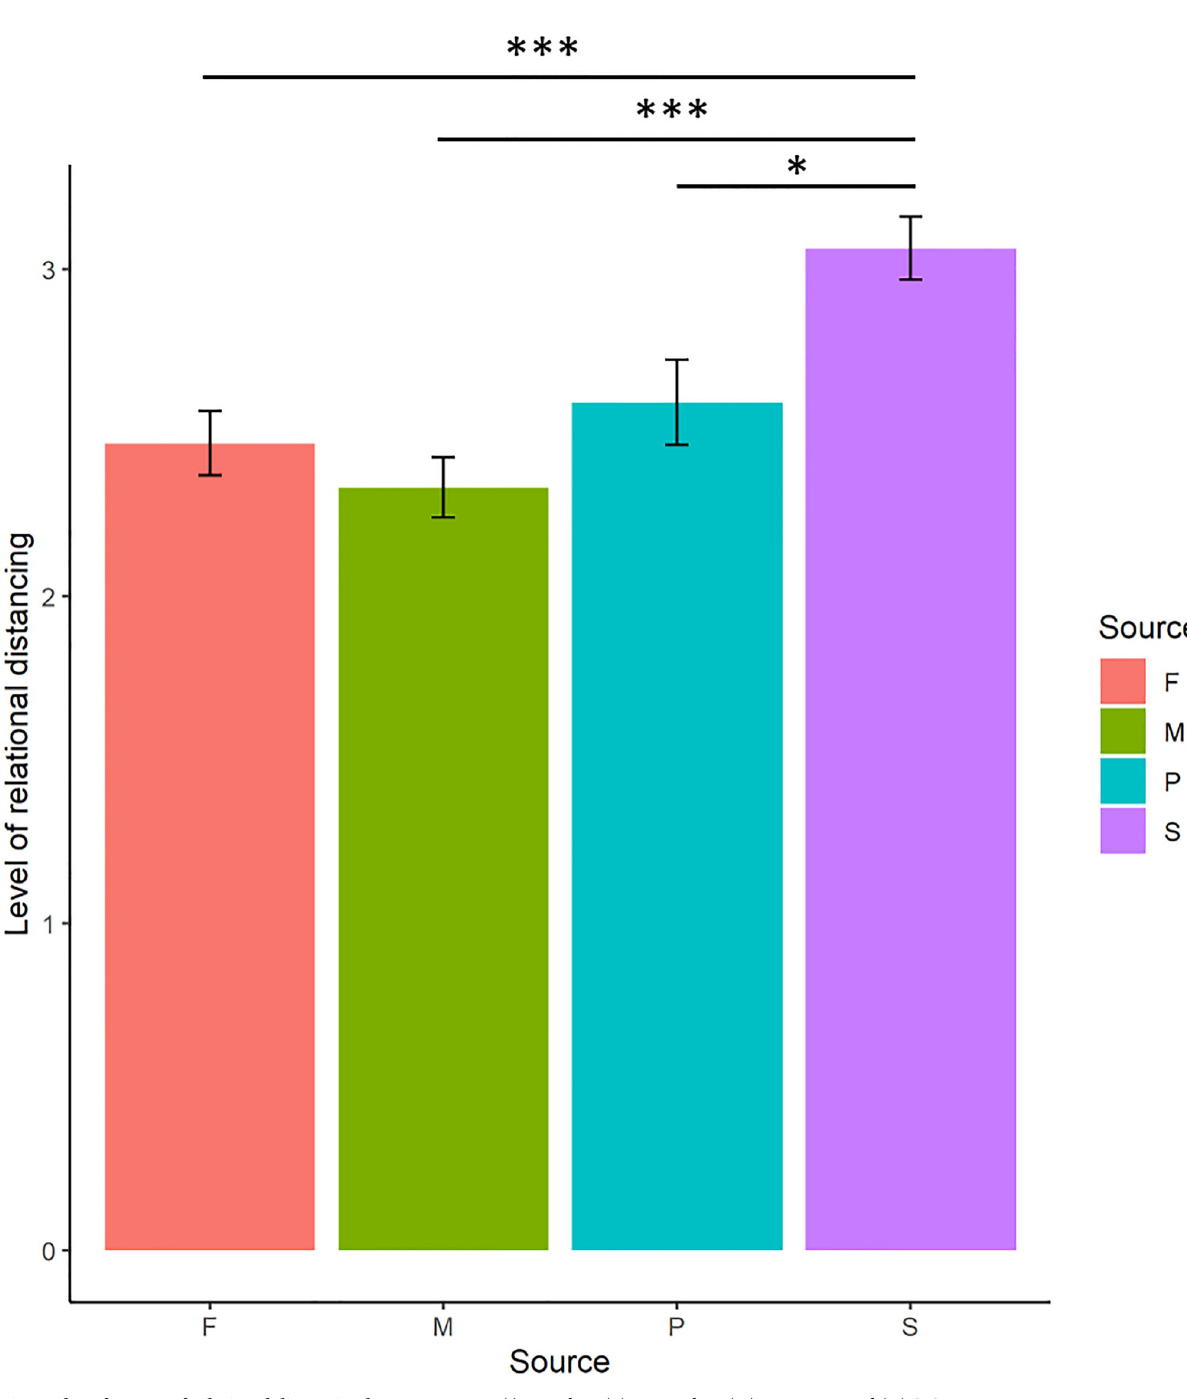
Fig 2. Plot of means of relational distancing by source. Note. (i) F: Father, (ii) M: Mother, (iii) P: Partner and (iv) S: